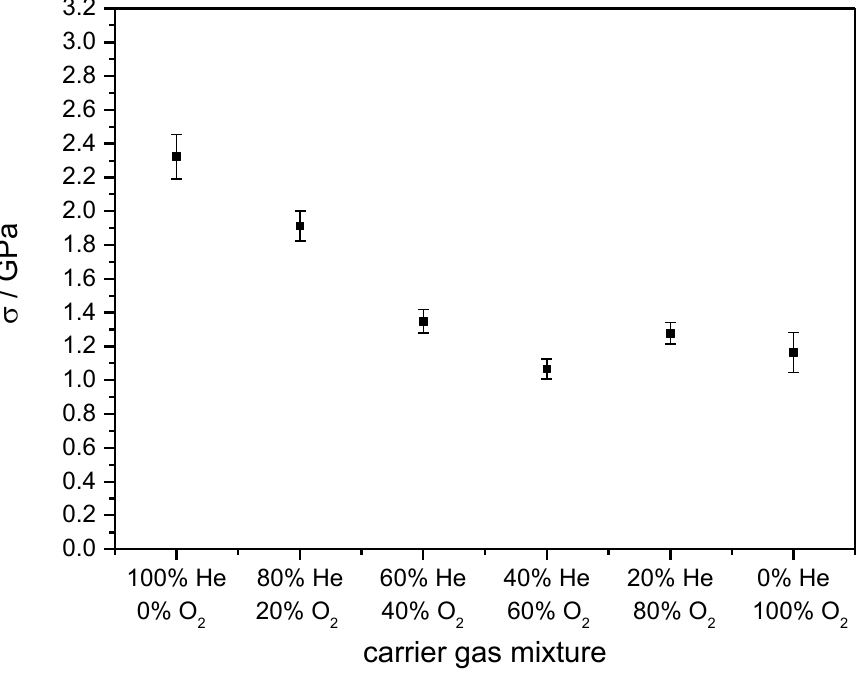
mixtures as carrier gas. Error bars describe 2